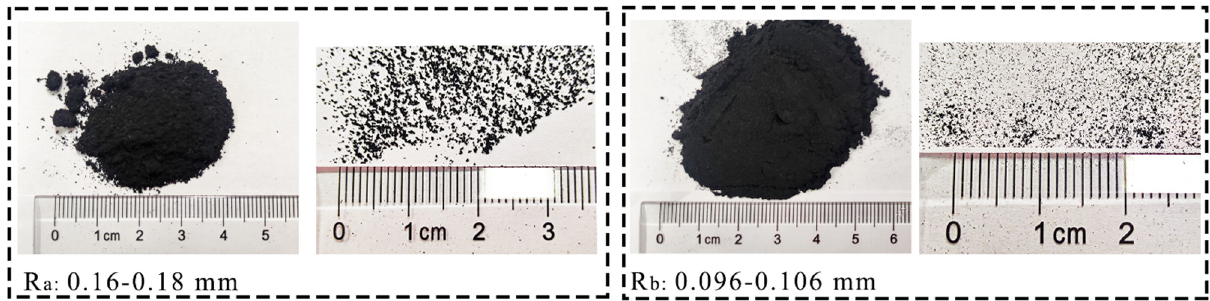
Figure 2. Two kinds of rubber powders R a and R b were selected for the